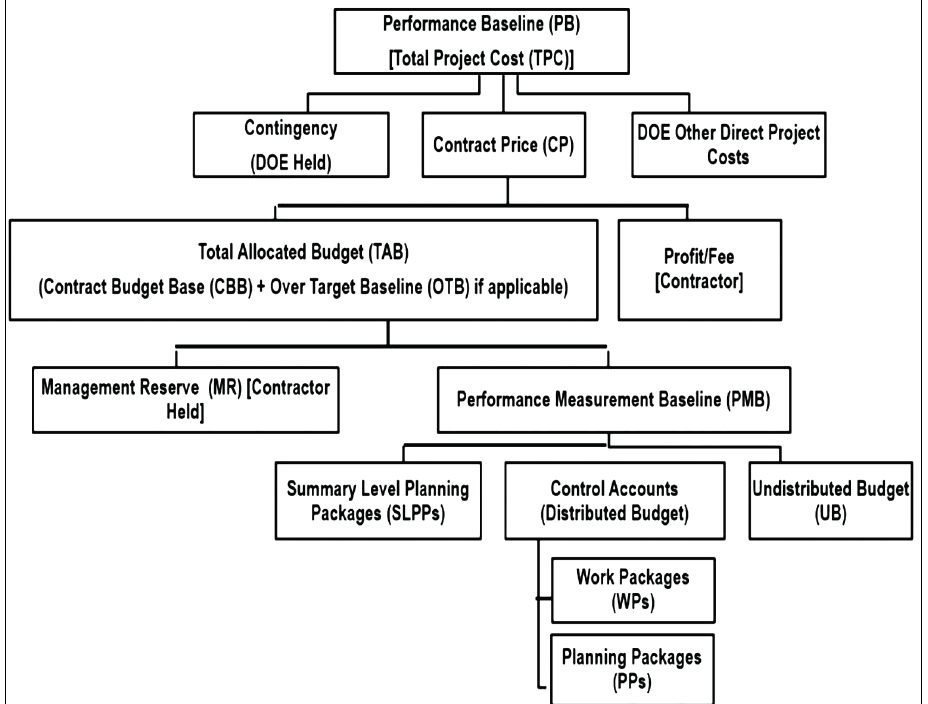
Fig. 12b. Budget hierarchy (DOE, 2016: